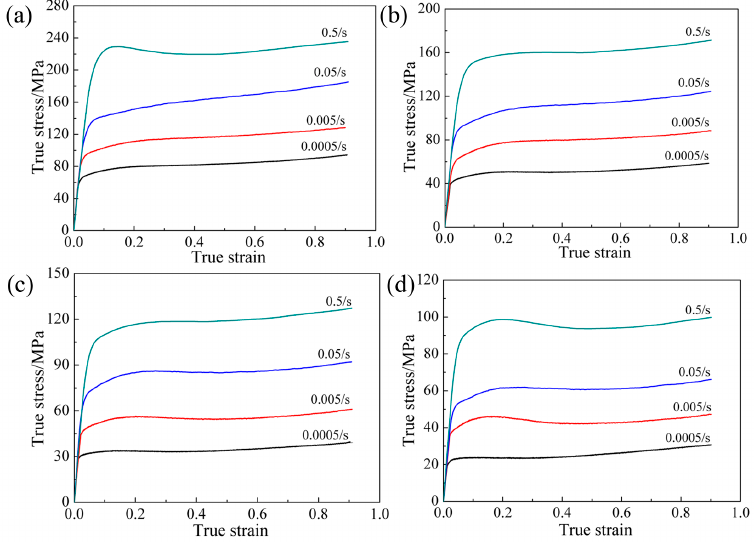
Figure 2. True stress-strain curves of NiTiCu SMA undergoing uniaxial compression at various strain rates and temperatures: ( a ) 700 °C; ( b ) 800 °C; ( c ) 900 °C; ( d ) 1000 °C.